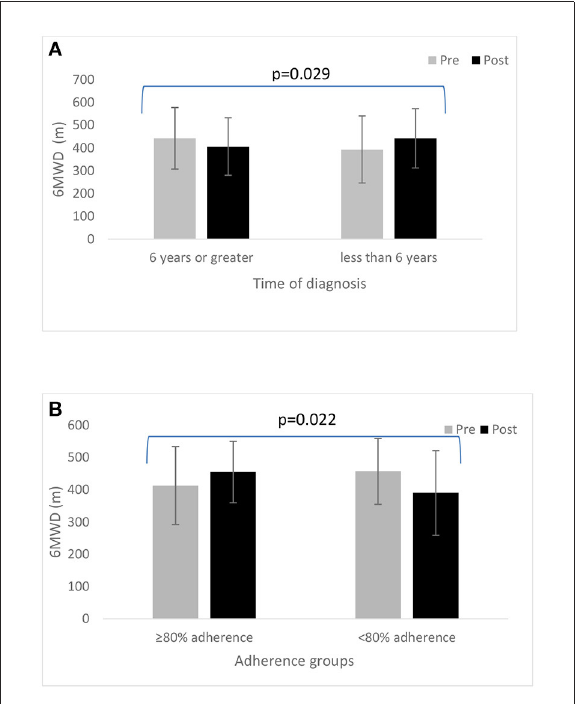
FIGURE2 (A) Change in 6 MWD from pre- to post-6-month BBFS program between those diagnosed with a neurological disorder for at least 6 years vs. < 6 years. (B) A comparison of 6MWD from pre- to post-6-month BBFS program between adherence groups ( ≥ 80 vs. < 80%) in those diagnosed with a neurological disorder for at least 6